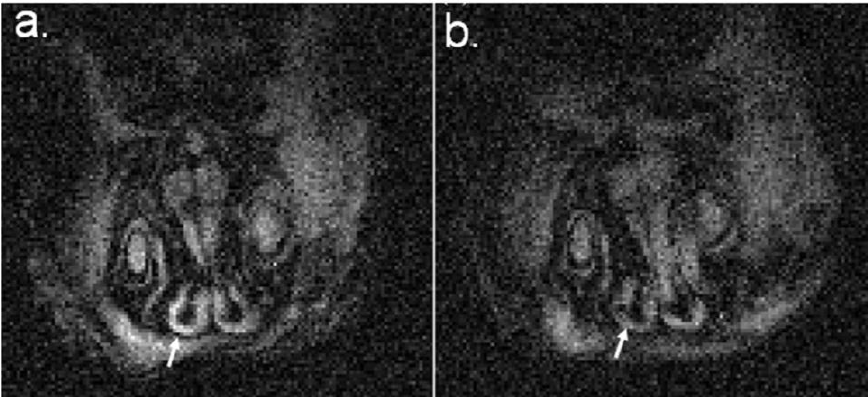
Figure 6. MRI tracking of iron oxide-modified NE in mice. MR images of a mouse sinus both before the administration of iron oxide-modified NE ( a ) and 15–30 min after administration ( b ). The relative loss in image intensity in the sinuses (arrows) from ( a ) to ( b ) is due to an increase in the T2* signal decay rate constant of the sinus. This is thought to be facilitated by the increased concentration of iron in the sinus. The T2* constant for the sinuses is measured to be 8.5 ms before administration 4.4 ms after administration ( p < 0.05).